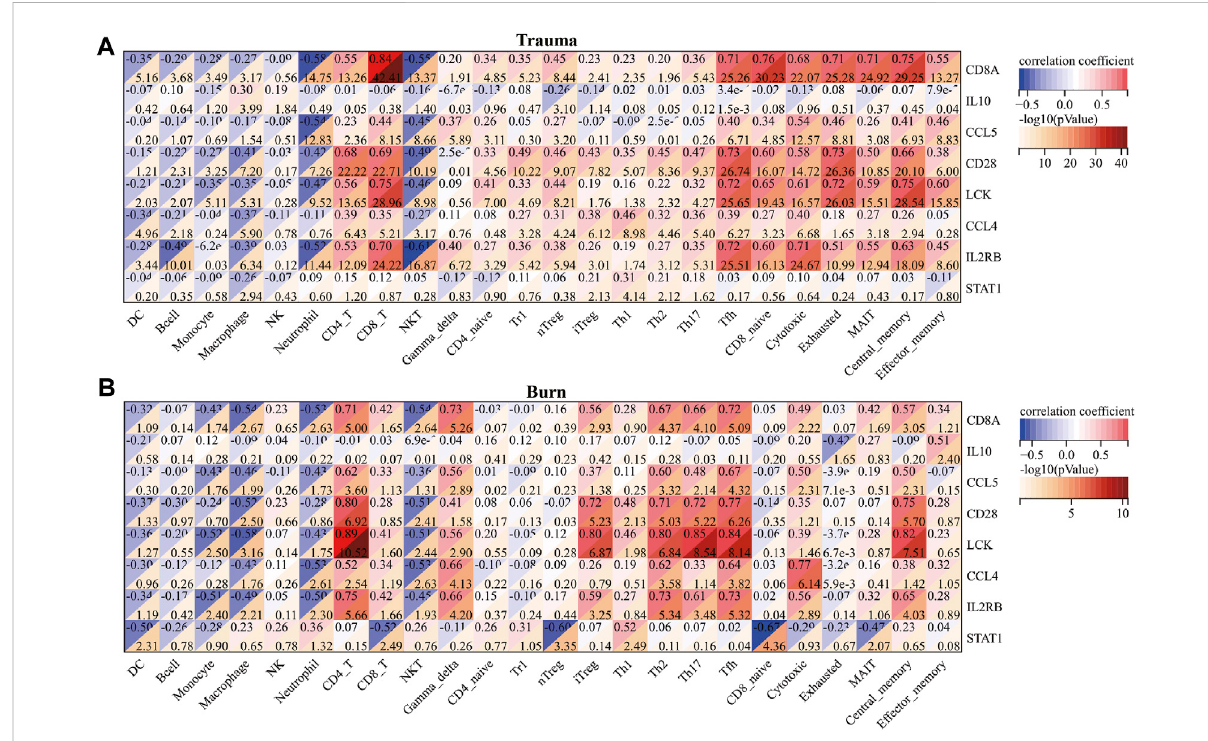
FIGURE 7 (A) Correlations between core immune-related DEGs and immune cell components in blunt trauma patients. (B) Correlation between core immune-related DEGs and immune cell components in burns